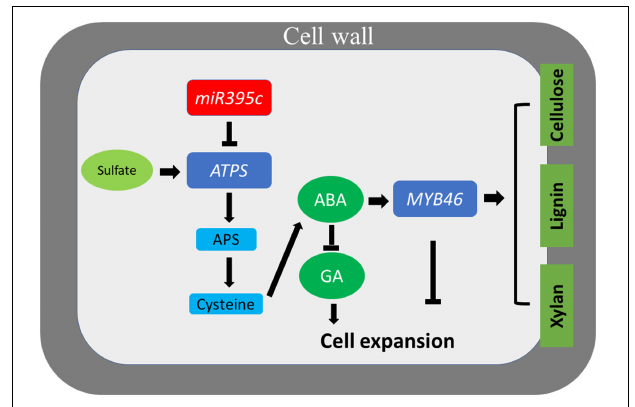
FIGURE 7 | A model for the role of miR395c in the development of xylem. Overexpression of miR395c downregulates ATPS , which then inhibits sulfate assimilation and synthesis of sulfate metabolic product cysteine. The decrease in cysteine inhibits the synthesis of ABA, which leads to an increase in the dimension of xylem vessels and a decrease in the thickness of fiber secondary walls by suppressing the expression of MYB46 . Increased GA, which is antagonistic to ABA, promotes cell expansion in miR395c-OE